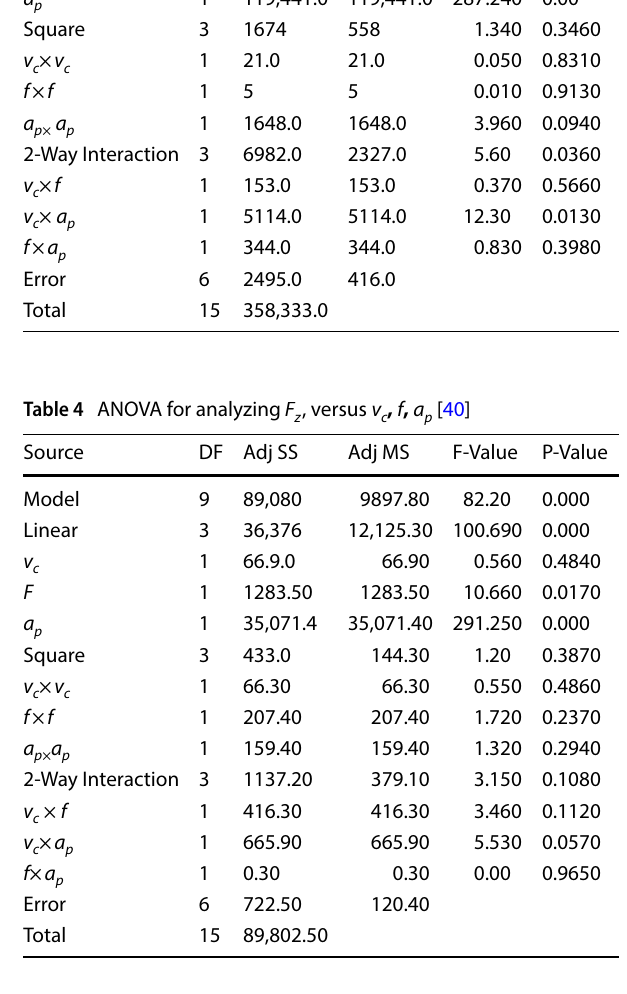
Table 3 ANOVA for analyzing F x versus v